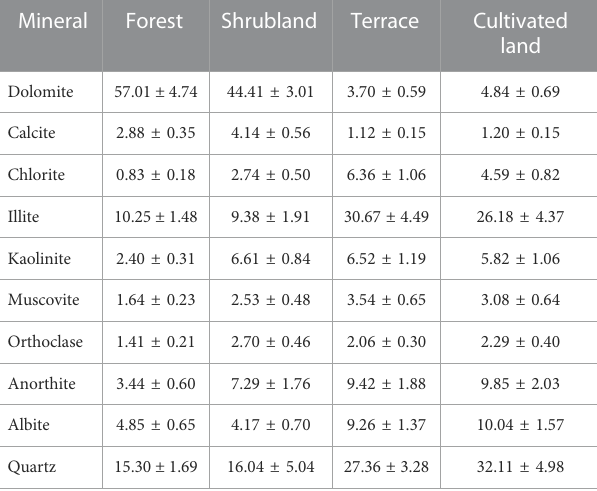
TABLE 1 Mass fraction of soil minerals using XRD with standard deviation